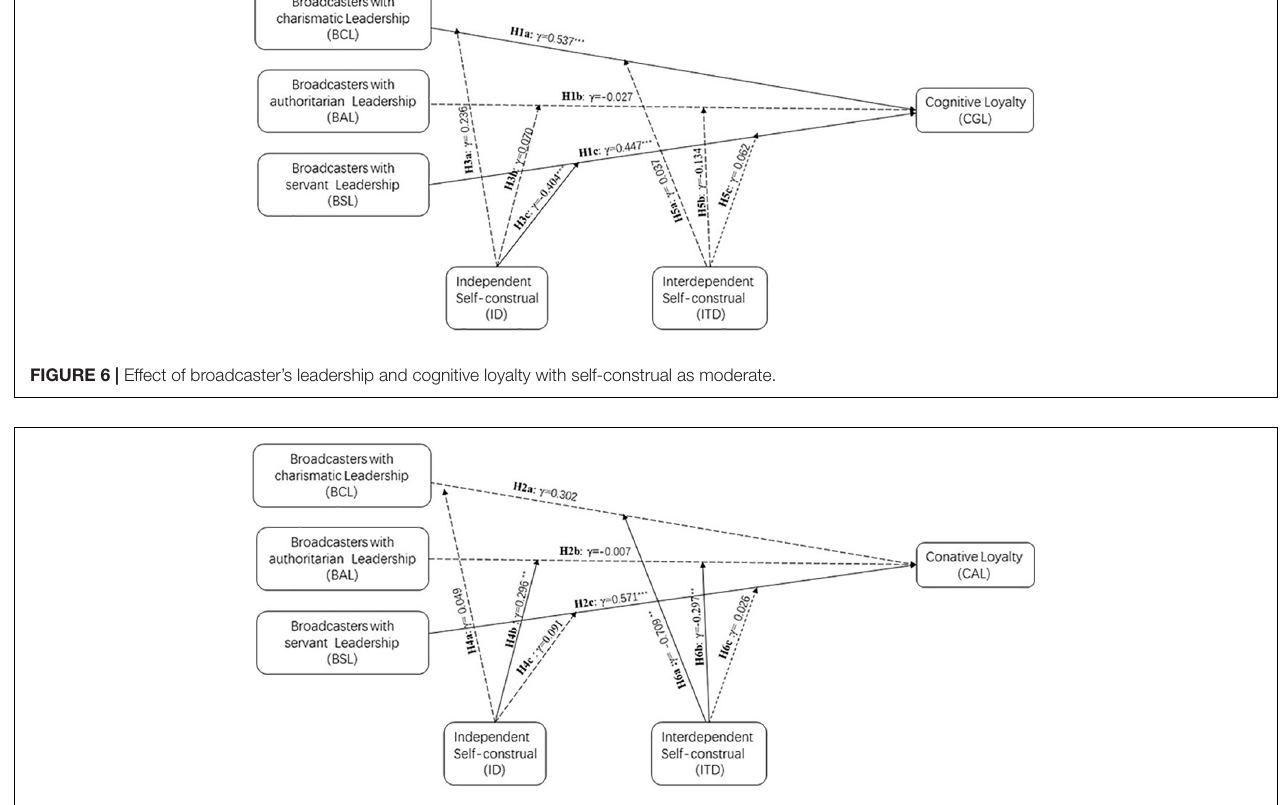
FIGURE 7 | Effect of broadcaster’s leadership and conative loyalty with self-construal as